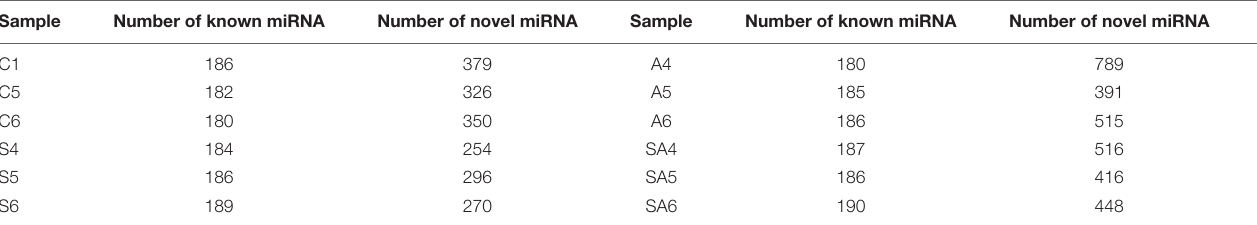
TABLE 3 | Number of known and novel miRNAs generated from tilapia gills small RNA library.